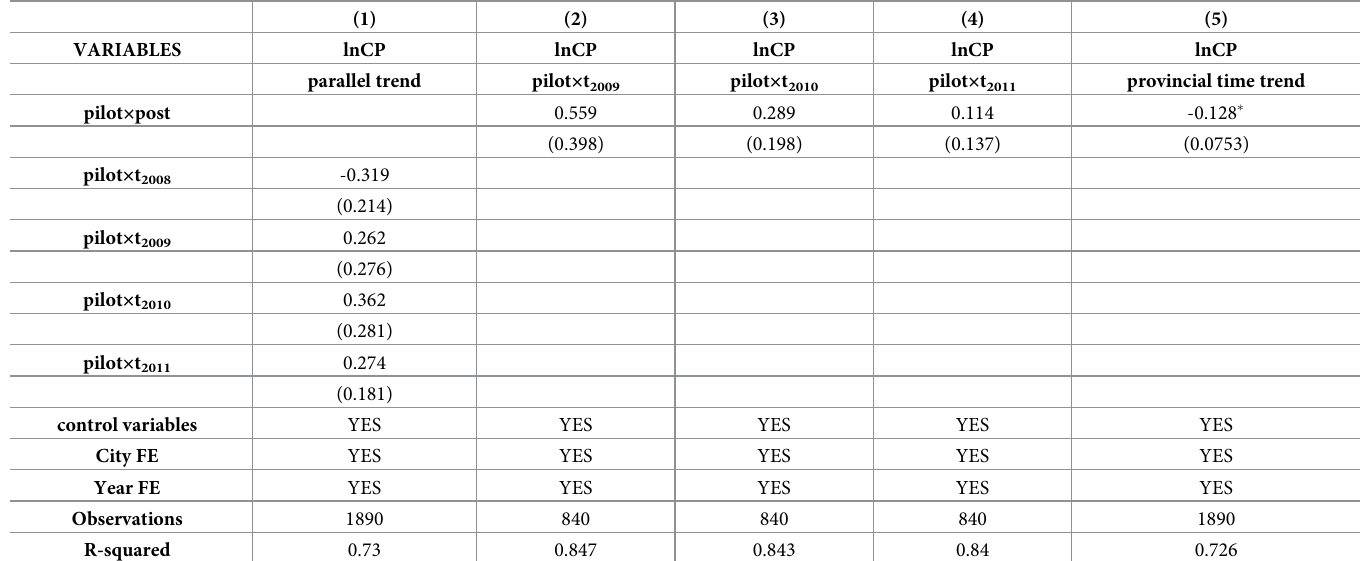
Table 3. Results of robustness